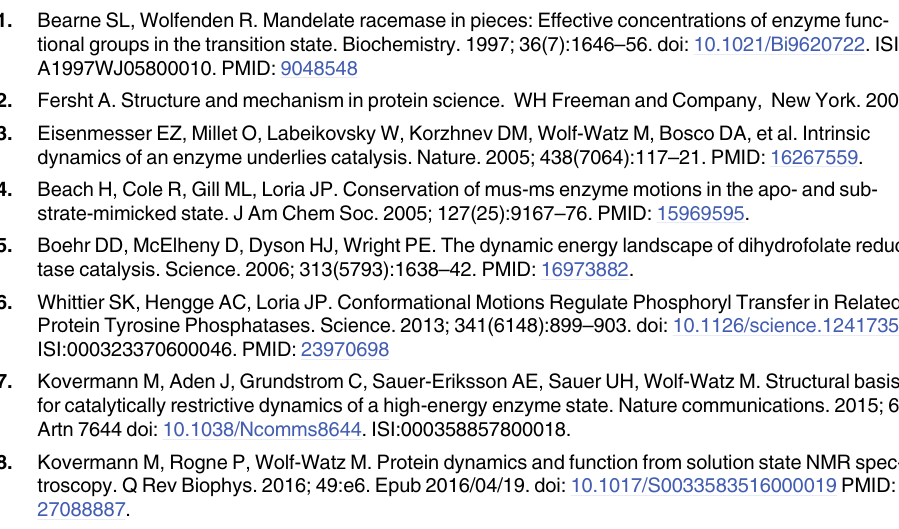
S2 Fig. 1 H- 15 N HSQC spectra of Adk R36A. S3 Fig. 1 H- 15 N HSQC spectra of Adk